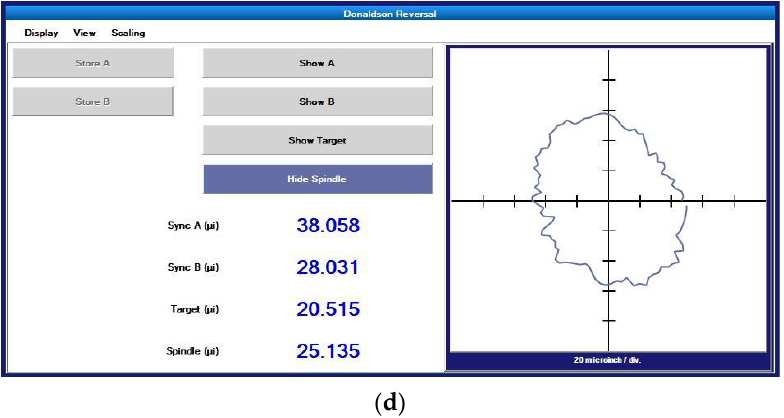
Figure 11. Donaldson reversal method measurement data: ( a ) synchronization error before reversal, ( b ) synchronization error after reversal, ( c ) roundness error of standard workpiece, ( d ) spindle radial error.